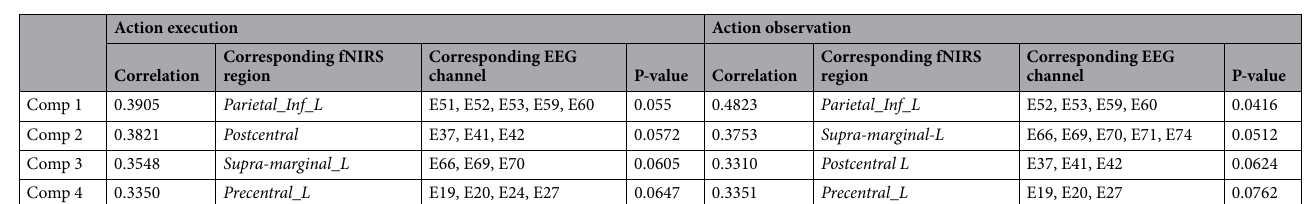
Table 1. The brain regions and their cross modality correlation and corresponding